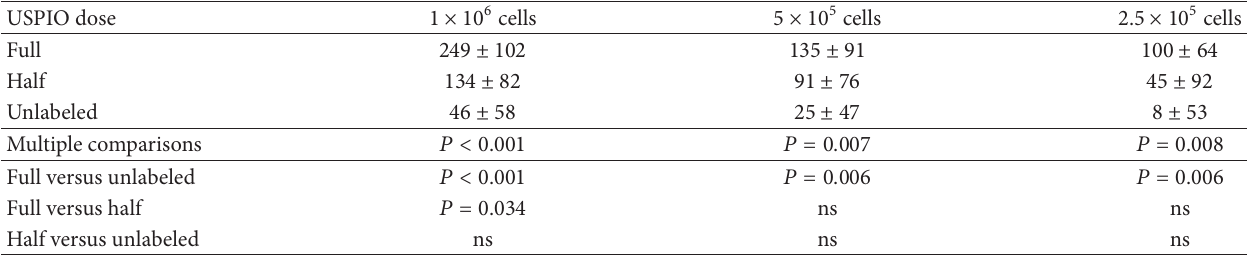
Table 3: MRI intensity differences after 21-hour USPIO incubation.